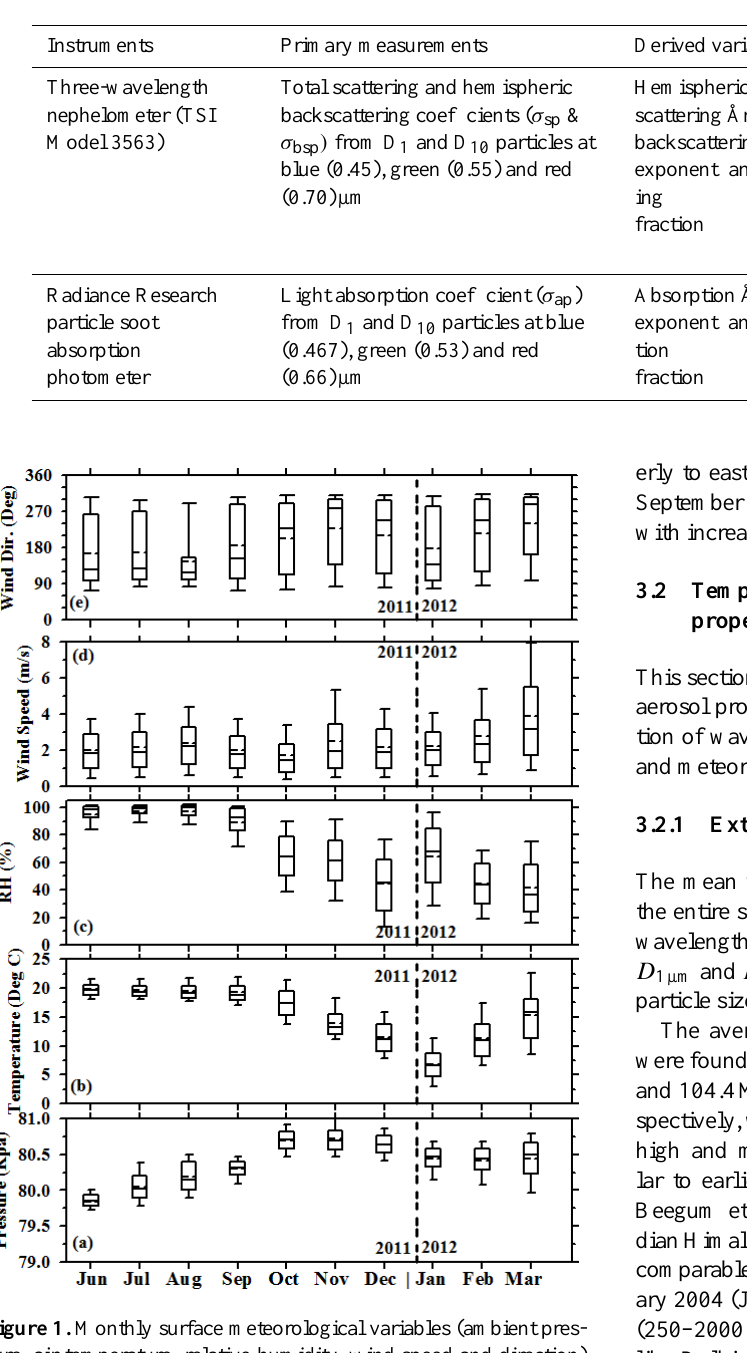
Table 1. Details of AOS instruments, variables and equations used for the calculation of aerosol optical properties.